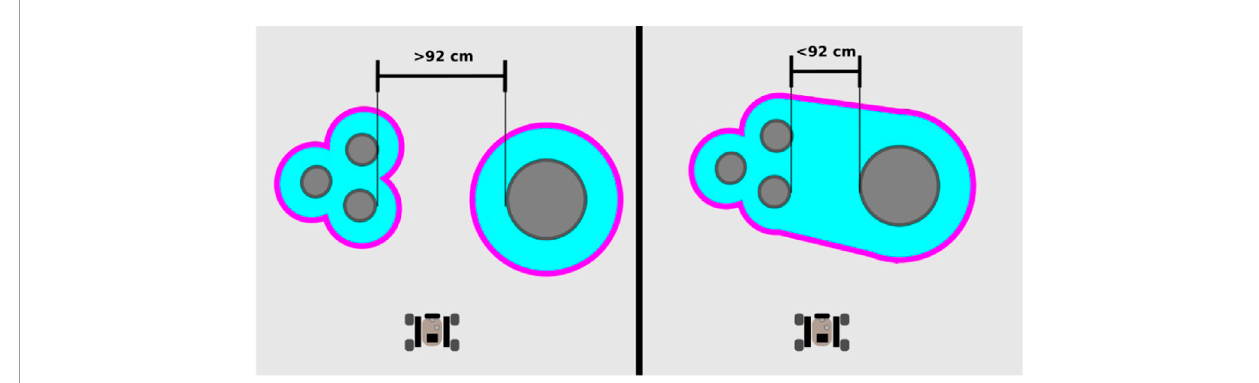
FIGURE 9 Graphical representation of the minimum clearance of the path planner. Objects closer than 92 cm are considered as too narrow for the planner to traverse in between those